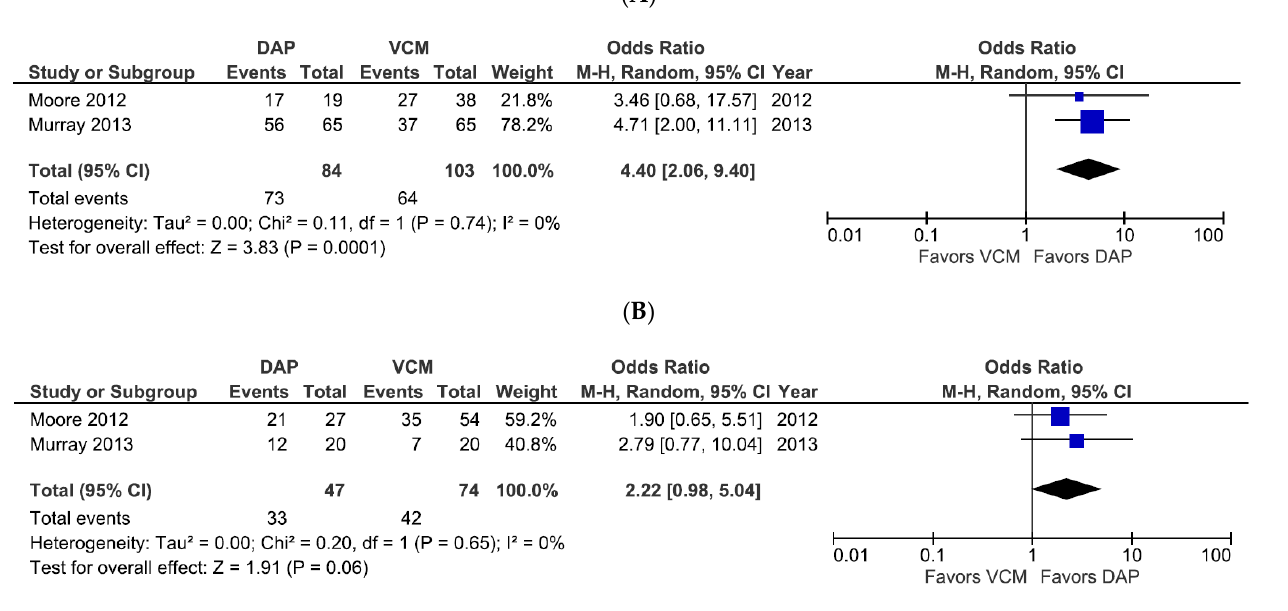
Figure 3. Forest plots of treatment success rates for patients treated with DAP versus VCM for bac- teremia caused by MRSA with VCM MIC > 1 µ g/mL, according to the infection risk level. ( A , B ) Forest plots of treatment success rates of patients treated with DAP versus VCM for intermediate-risk ( A ) and high-risk ( B ) sources of infection. Symbols and abbreviations are as described in Figure 2.